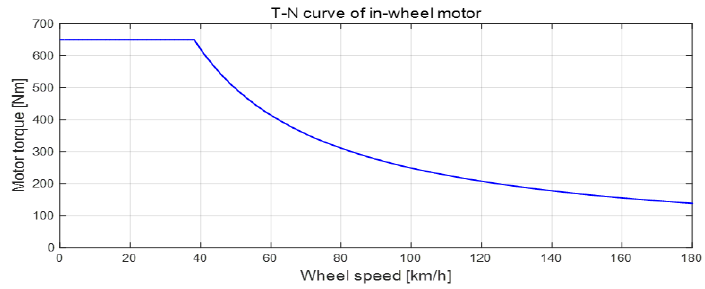
Figure 4. Maximum IWM torque.